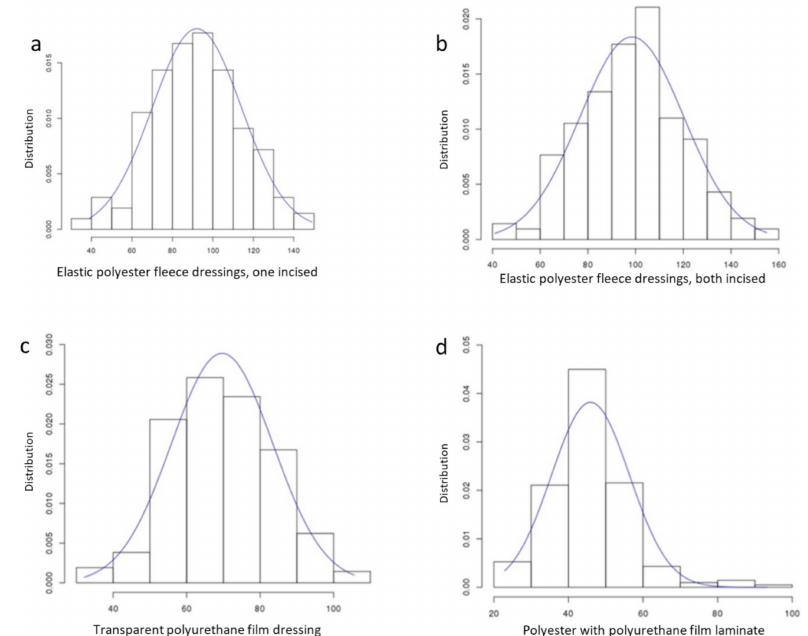
Figure 5. Force distribution of four securement methods: ( a ) elastic polyester fleece dressings, one incised; ( b ) elastic polyester fleece dressings, both incised; ( c ) transparent polyurethane film dressing; ( d ) polyester with polyurethane film laminate. Curves show fitted Gaussian distributions.